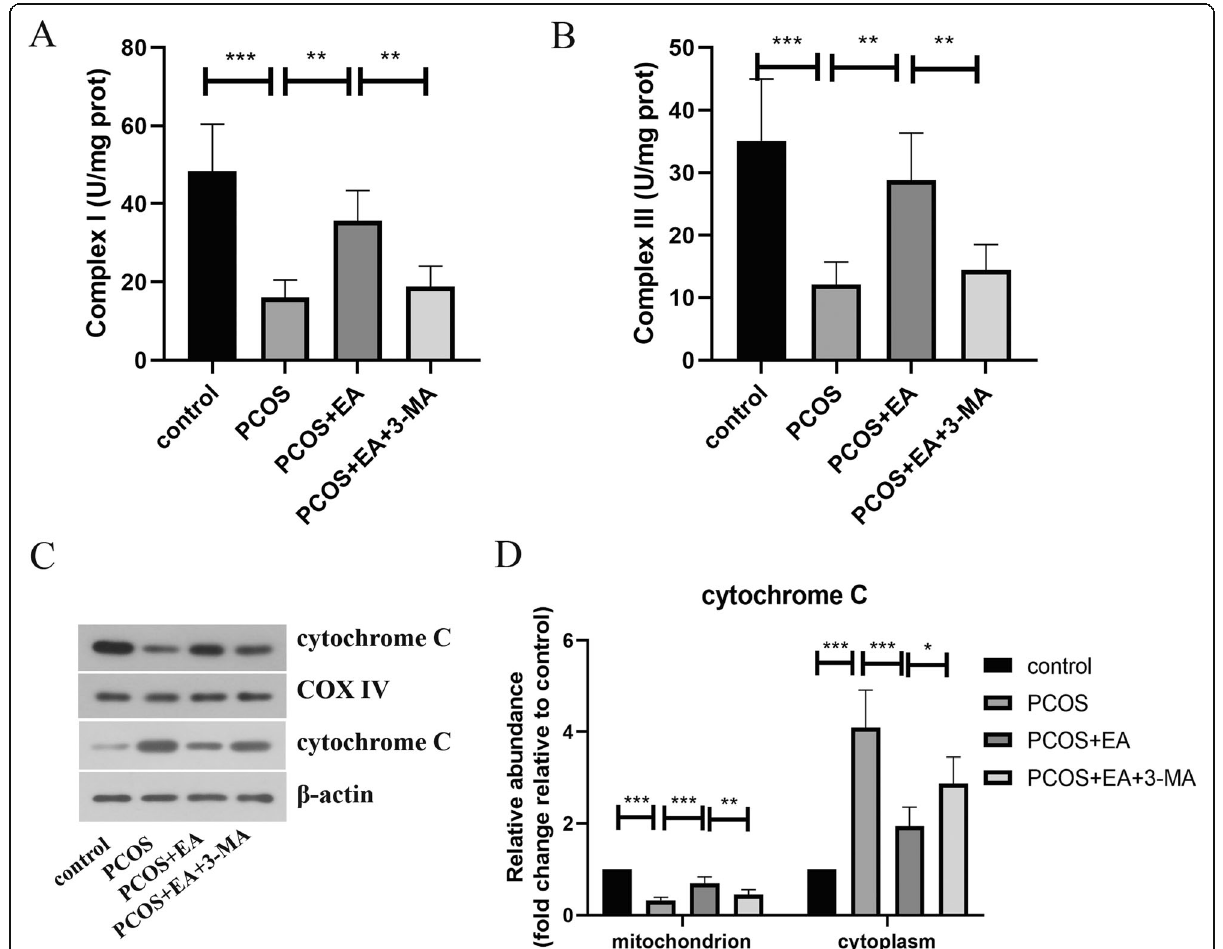
Fig. 5 EA improved mitochondrial dysfunction in PCOS rats via enhancing autophagy. The activities of Complex I ( a ) and Complex III ( b ) in ovarian tissues were detected. c & d Western blotting for determining the protein level of cytochrome C in mitochondrion and cytoplasm of ovarian tissues. The experimental data are presented as mean ± standard deviation (n = 6). * P < 0.05, ** P < 0.01, *** P < 0.001, vs the indicated group. EA, electroacupuncture; PCOS, polycystic ovary